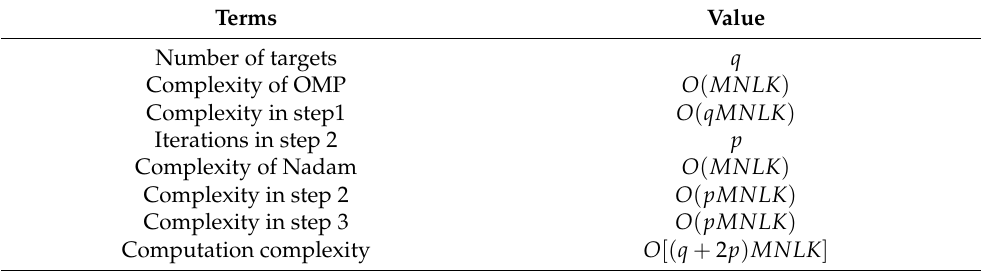
Table 2. Complexity terms.